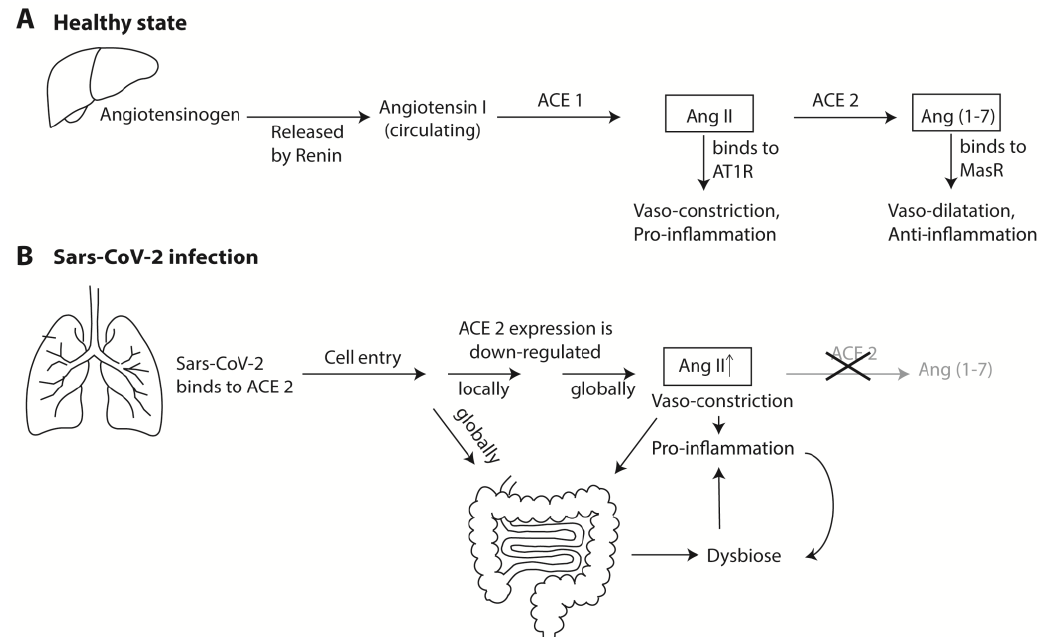
Figure 2. The roles of ACE1 and ACE2 as part of the Renin–Angiotensin System (RAS) in health and during SARS-CoV-2 infection. Panel A shows the production of Ang II and Ang(1-7) from angiotensinogen after it is produced in the liver. Their antagonistic effects on blood pressure and inflammation are shown. Alternative routes from Angiotensin 1 to give Ang II are not shown, and alternative components, receptors, and pathways are omitted for simplicity. Panel B summarizes the pro-inflammatory effect of ACE2 repression during SARS-CoV-2 infection. The gut increases the proinflammatory state with positive feedback loops.